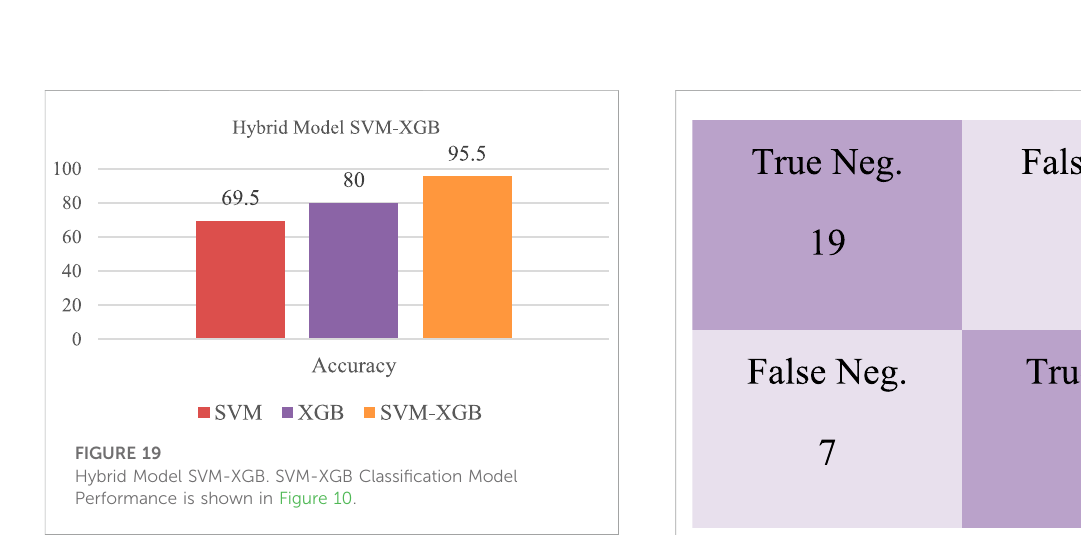
FIGURE 20 The confusion matrix of SVM-GBC Classi fi cation